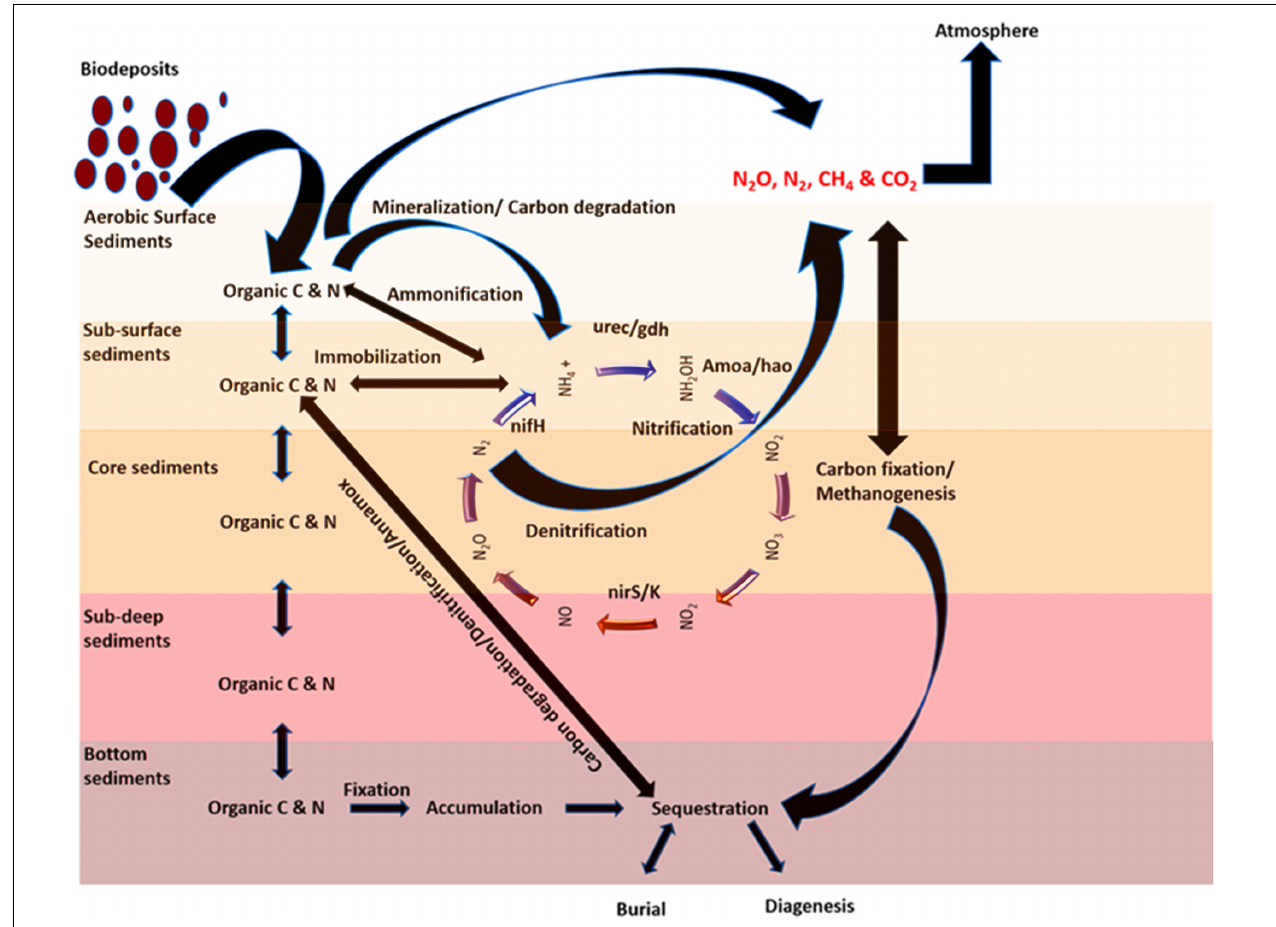
FIGURE 8 | A conceptual model showing the biological process during the carbon and nitrogen cycle under an OBD